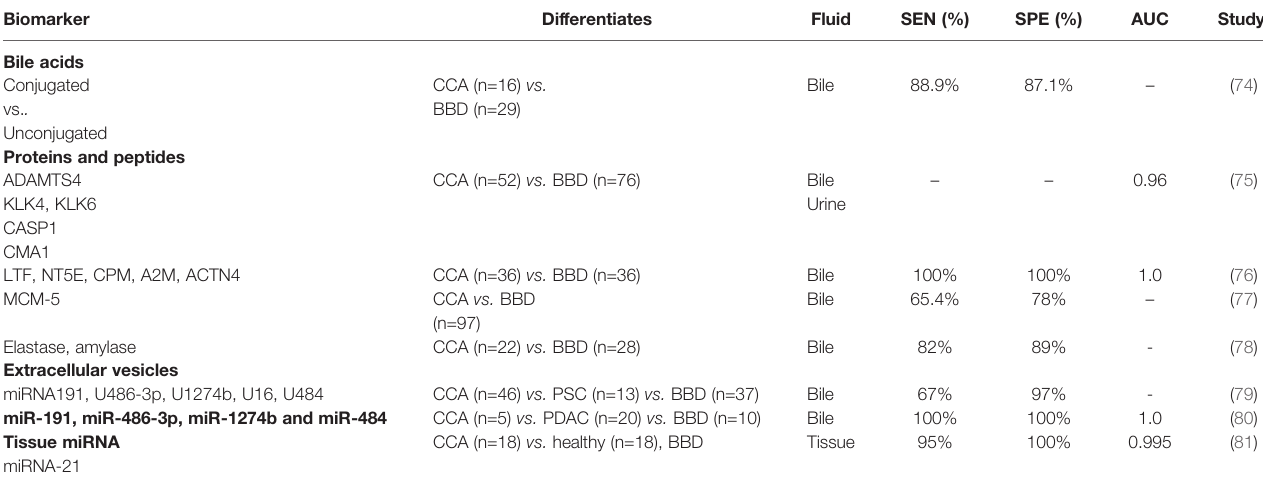
TABLE 2 | Bile and tissue